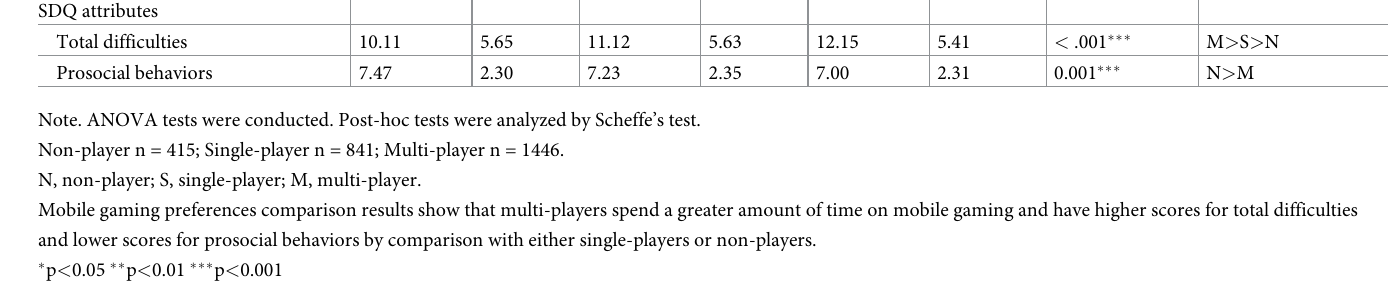
a poor parent-child relationship, and residence in China (Table 5).